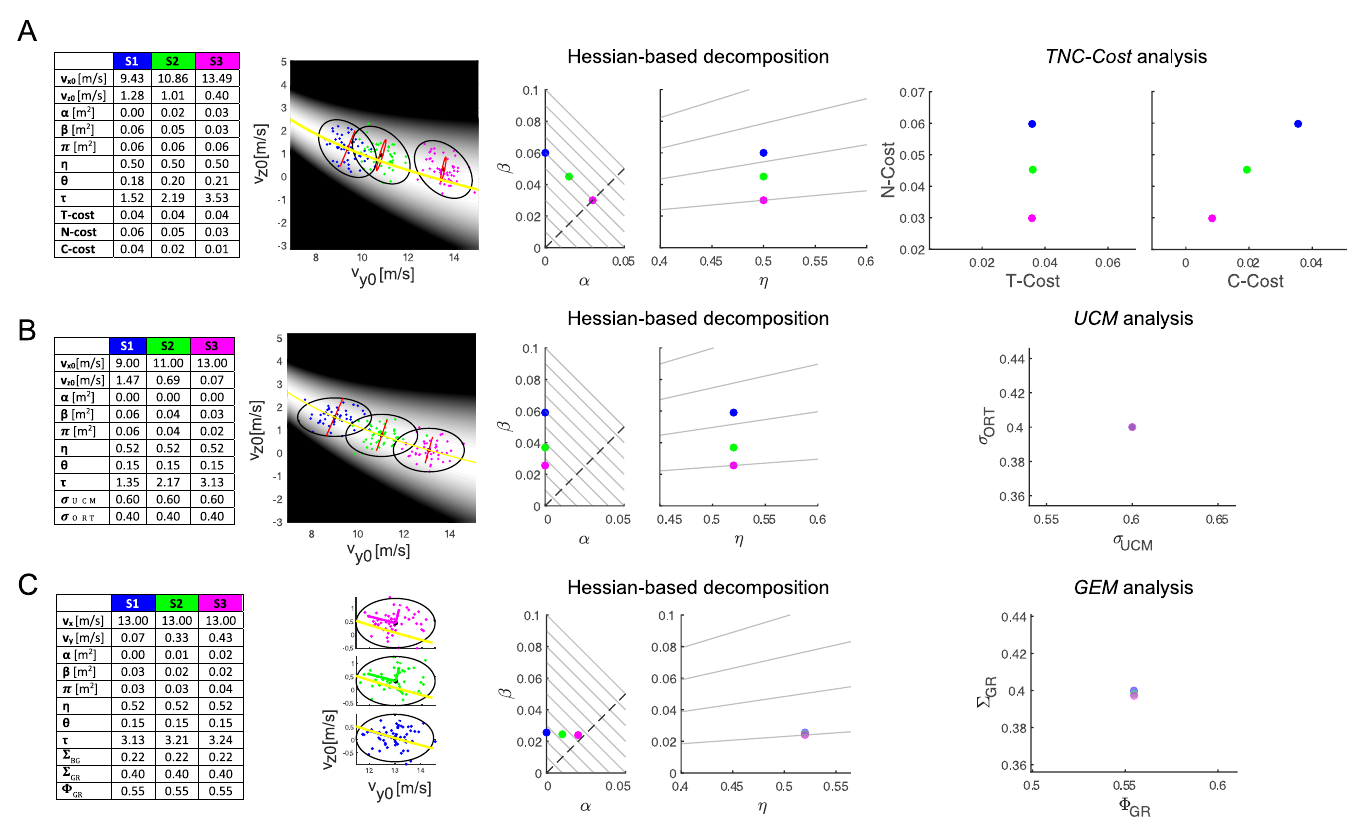
Fig 4. Comparison of the Hessian-based decomposition with existing computational methods for the analysis of throwing strategies in a 2D throwing task. (A) Comparison with TNC-Cost analysis. Three strategies ( S 1 blue , S 2 green , S 3 magenta ) are simulated by generating a distribution of 50 release parameters ( v randomly sampling from a bi-dimensional Gaussian distribution with a given mean and covariance (see parameters in the table on the left ). The strategies have the same performance because they trade-off bias ( α ) with tolerance-variability ( β ), as can be clearly observed in the α - β scatter plot. Moreover, the strategies have equal noise ( η ). However, the strategies have equal T-cost but different N-Cost, which then represent a recombination of the indicators extracted from the Hessian-based decomposition. Moreover, as the TNC costs do not sum up to the performance, the α - β tradeoff cannot be observed. (B) Comparison with UCM analysis. Three simulated strategies with no bias (i.e. with a mean action on the solution manifold) differ in performance because of differences in β , due to differences in the alignment of the covariance ( black ellipses) with the Hessian ( red degenerate ellipses), since the noise is equal. The decomposition of the action variability onto an uncontrolled manifold (UCM) subspace and an orthogonal (ORT) subspace does not discriminate the three strategies. (C) Comparison with GEM analysis. Three simulated strategies with equal noise but different performance due to differences in α are not discriminated by the goal-relevant sensitivity S GR and the goal-relevant variability fraction F GR